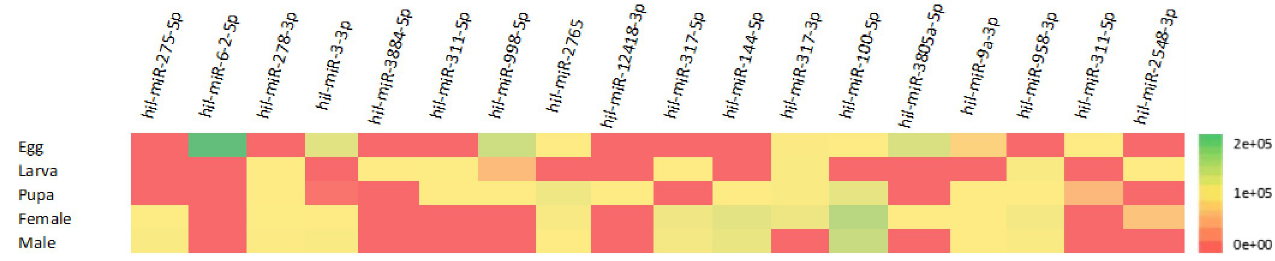
Fig 1. Heatmap of conserved microRNA expression with a log fold change (LFC) of ± 10 (p-adjusted value < 0.05) across life stages.